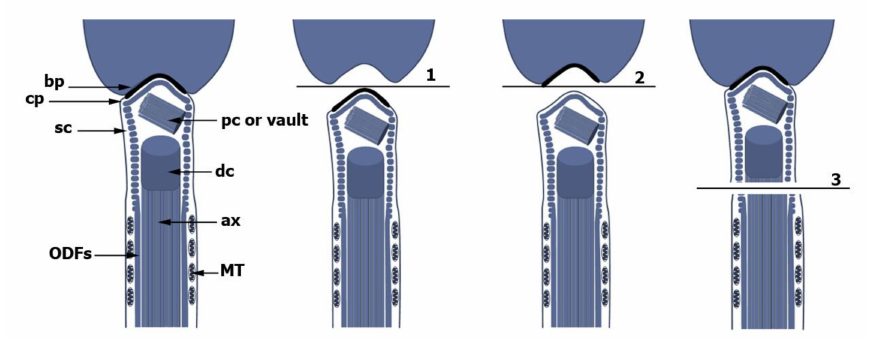
Figure 4. Sperm decapitation occurs at three different positions. Compared to the intact spermato- zoon (left), breakage line 1 is between the nuclear envelope and the basal plate and has been observed in Odf3 / Pmfbp1 -ko mice. The basal plate thus remains attached to the tail. Breakage line 2 separates the basal plate from the capitulum. The basal plate remains therefore associated with the nucleus. This is the most common case. Breakage line 3 separates the neck region, which remains attached to the nucleus, from the mid-piece, and was found in spermatozoa with a heterozygous deletion of Odf2 . Since the scheme was assembled from data obtained from infertile patients with ASS as well as from mice, the positions of distal and proximal centrioles, dc and pc, respectively, are shown. However, it has to be mentioned that typical distal centrioles are no longer present and that in mice the proximal centriole disintegrates, too. Instead, atypical distal centrioles and a vault in the place of the former proximal centriole (pc) in mice are found. ODFs, outer dense fibers; MT, microtubules; ax, axoneme; sc, segmented columns; cp, capitulum; bp, basal